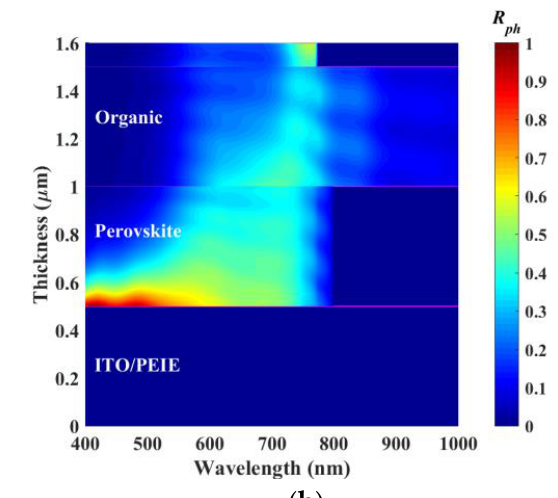
Figure 3. EQE Simulation results for different values of ( a ) trap densities and ( b ) thickness of perovskite layer.